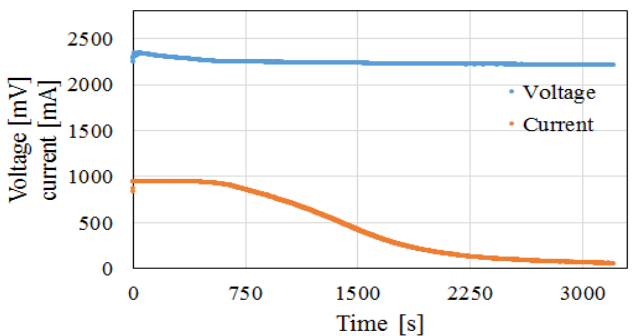
Figure 9. Discharging characteristic of Ni-MH 2 cell in series during CCCV mode.